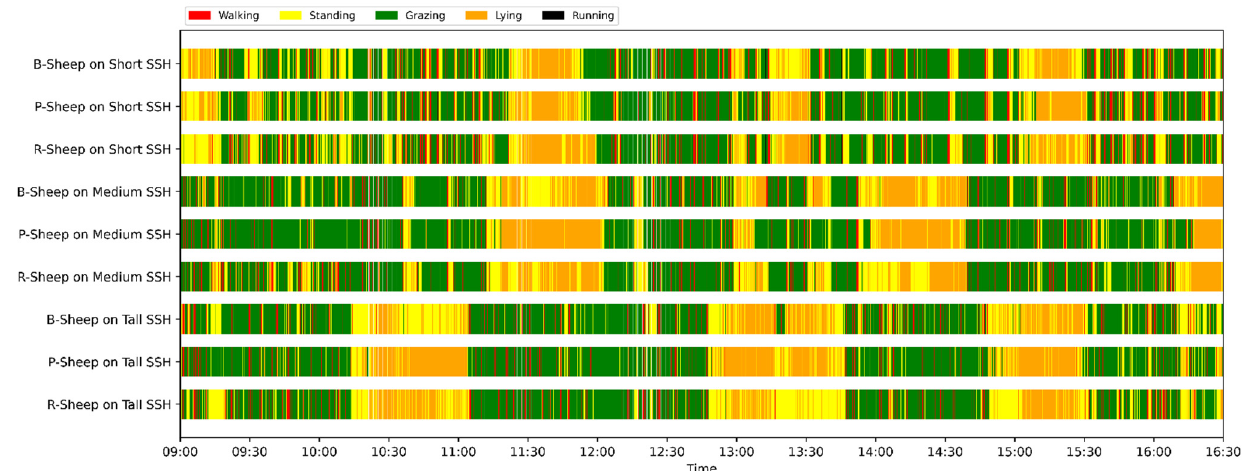
Figure 12. Behavior distribution of three grazing sheep on pastures with three different sward surface heights (SSH) classified by the trained stacking model. Table 9. Percentage of behavior time of the three grazing sheep for 7.5 h on pasture with three dif- ferent sward surface heights (SSH).